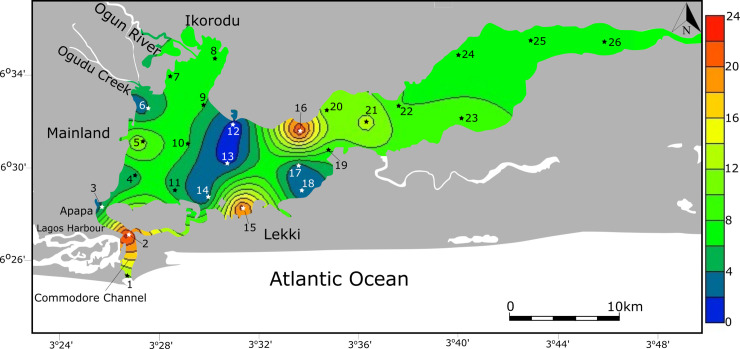
Map summarizing color-coded species richness values at each sampling location.